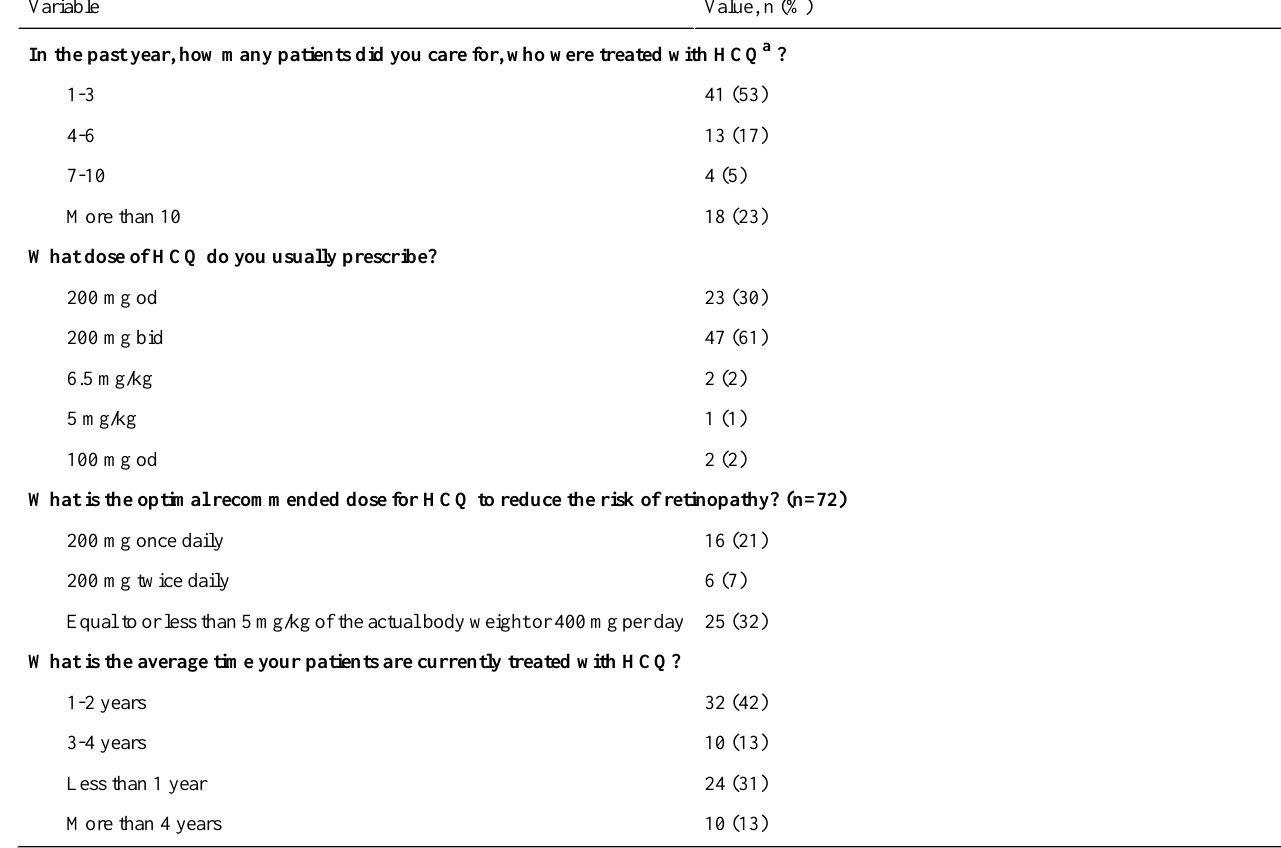
Table 2. Dermatology practice–related